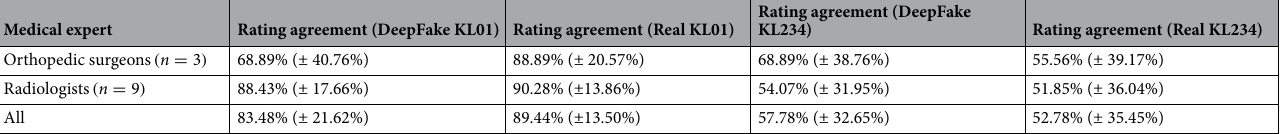
Table 3. Average agreement between our medical expert labels, the original, and DeepFake labels. The agreement score is the average accuracy of all individual accuracy scores per medical expert. The standard deviation is shown in